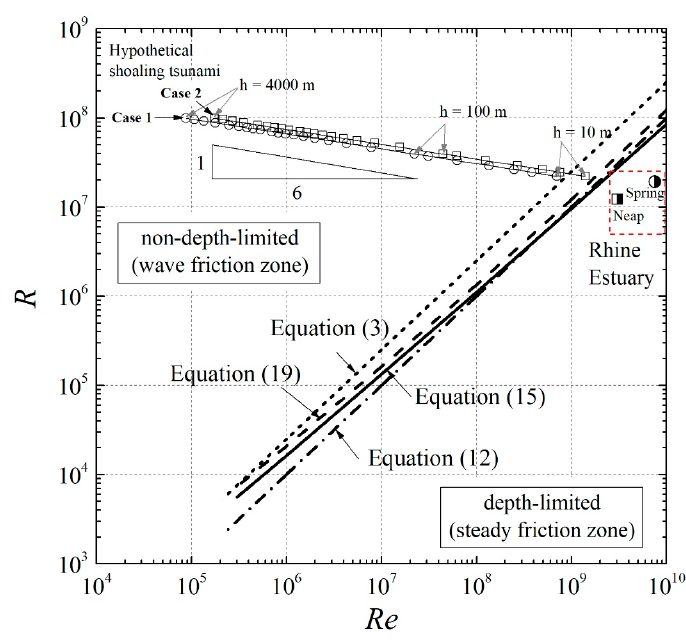
Figure 8. Application of the demarcation conditions to the Rhine Estuary and to a hypothetical tsu-